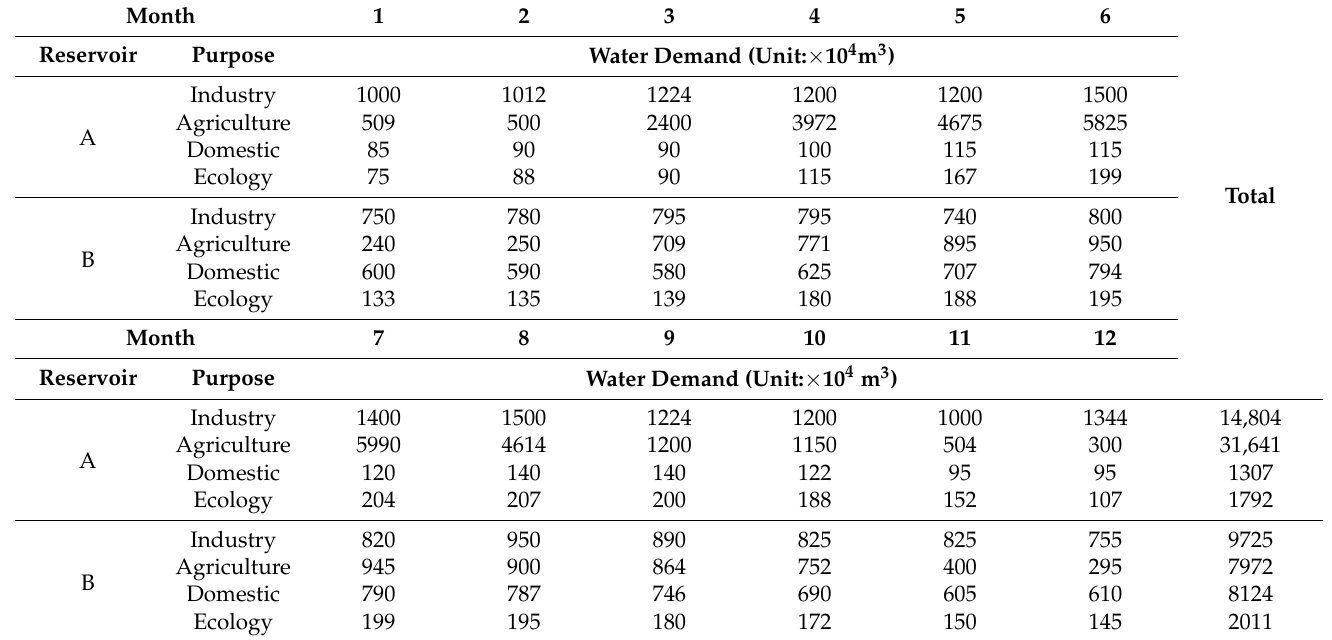
Table 2. Water demand from reservoir A and reservoir B over different periods of